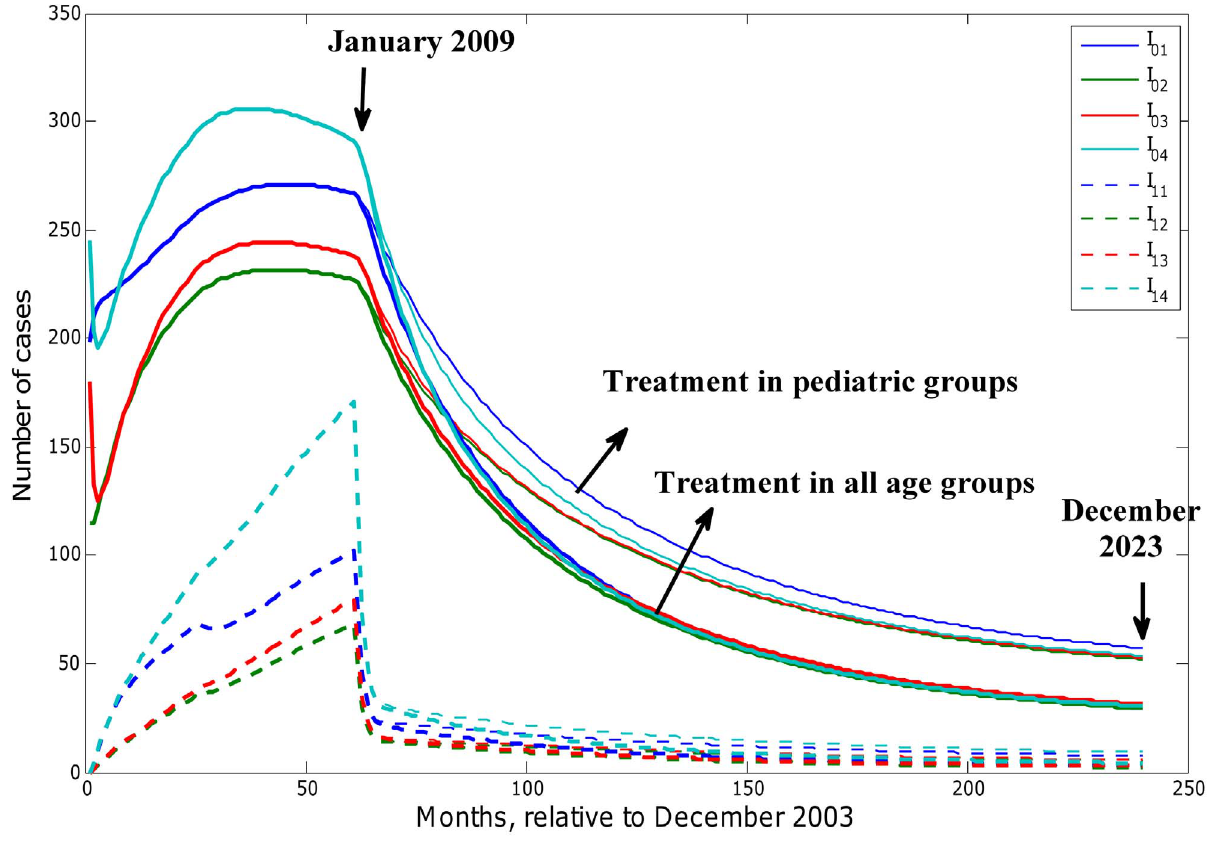
Figure 6. Model prediction for first-time and recurrent infections for pediatric groups until December 2023 with mean parameter values and different decolonization treatment coverage after 2008. 100% coverage for the first 4 age groups and 0 for adult groups (slim lines); 2). 100% coverage for the whole population (bold lines). The age-specific decolonization treatment coverage for till 2008 are time-dependent step functions with extreme values given by Table S1 for 4 pediatric groups and 0 for 2 adult